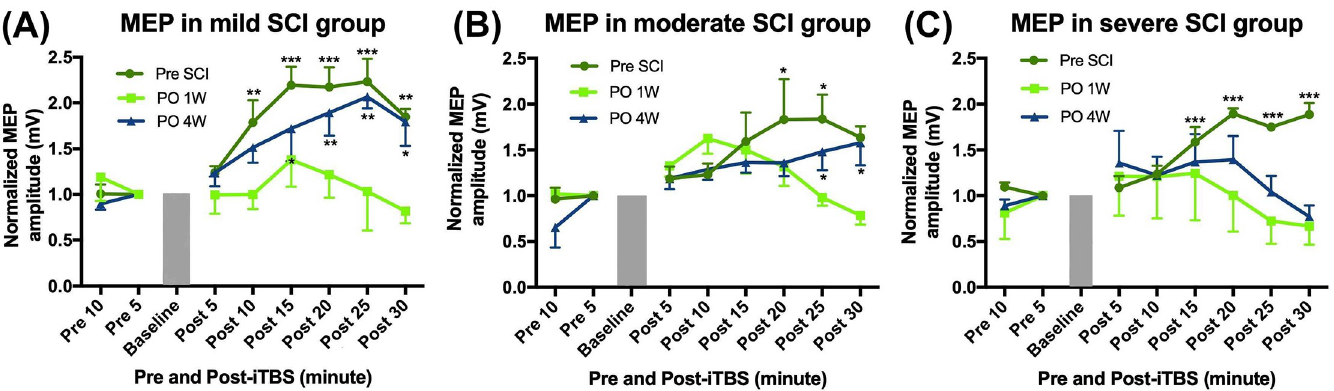
Fig 3. Single intermittent theta-burst stimulation (iTBS) effect on the motor-evoked potential (MEP) amplitude. Time course of average changes in the MEP amplitude from the mild-spinal cord injury (SCI) group (A), moderate-SCI group (B), and severe-SCI group (C). Each point corresponds to the mean and standard error of the MEP amplitude expressed as a ratio to the last block of baseline responses. � p < 0.05, �� p < 0.01, ��� p < 0.001, by post-hoc Fisher’s LSD test on the MEP size: between each time point post-SCI compared to the MEP amplitude average of the last block pre-iTBS.